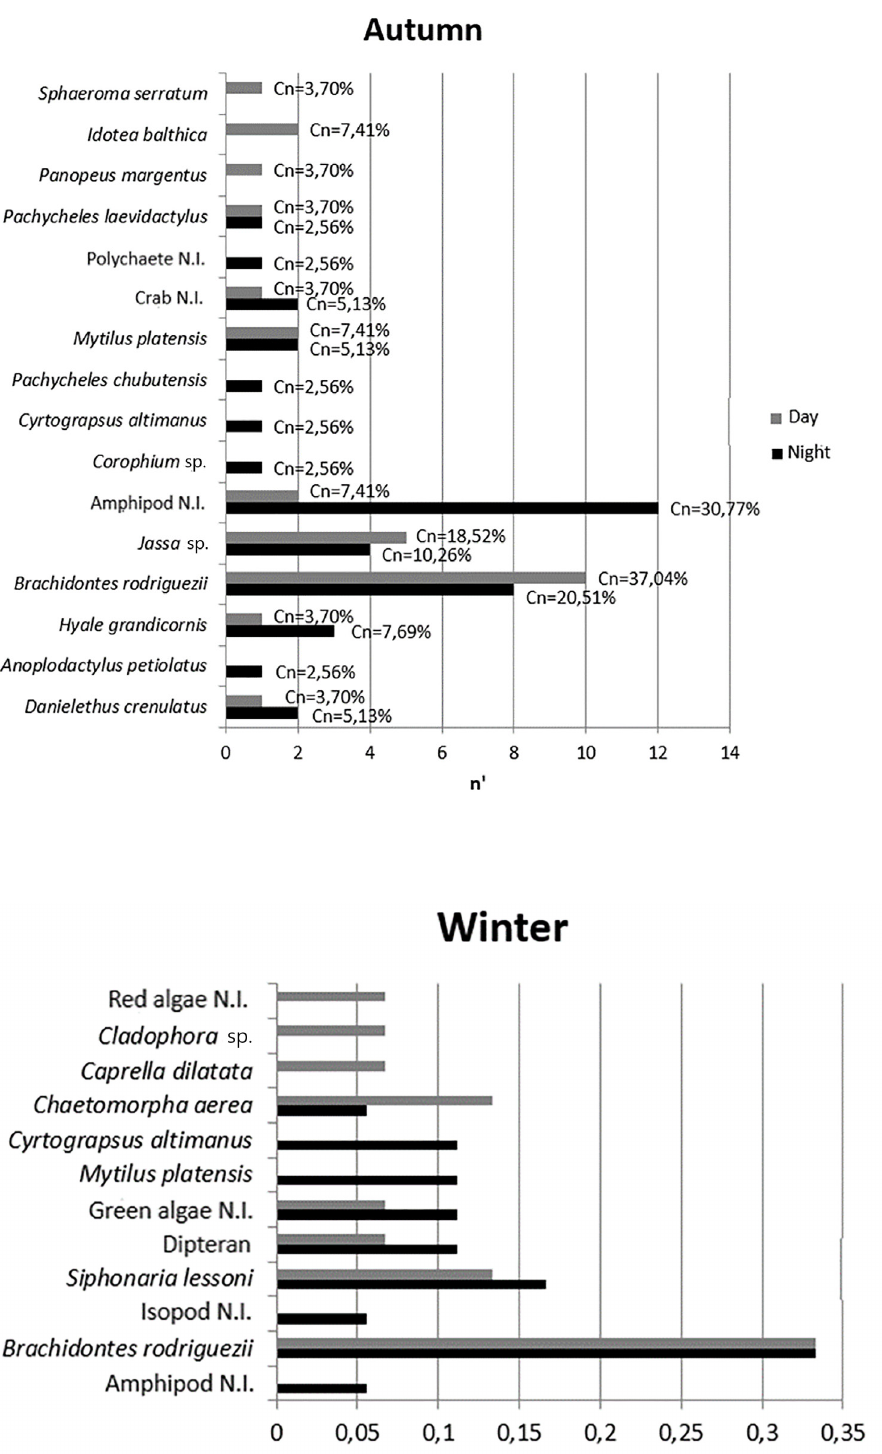
Figure 3. Number of individuals of each type of prey (n’) present in the gastral cavities of Bunodosoma zamponii during diurnal and nocturnal high tides in autumn. N.I. = unidentified. Cn = percentage of prey. Only those prey in which the number of individuals could be quantified were taken into account.